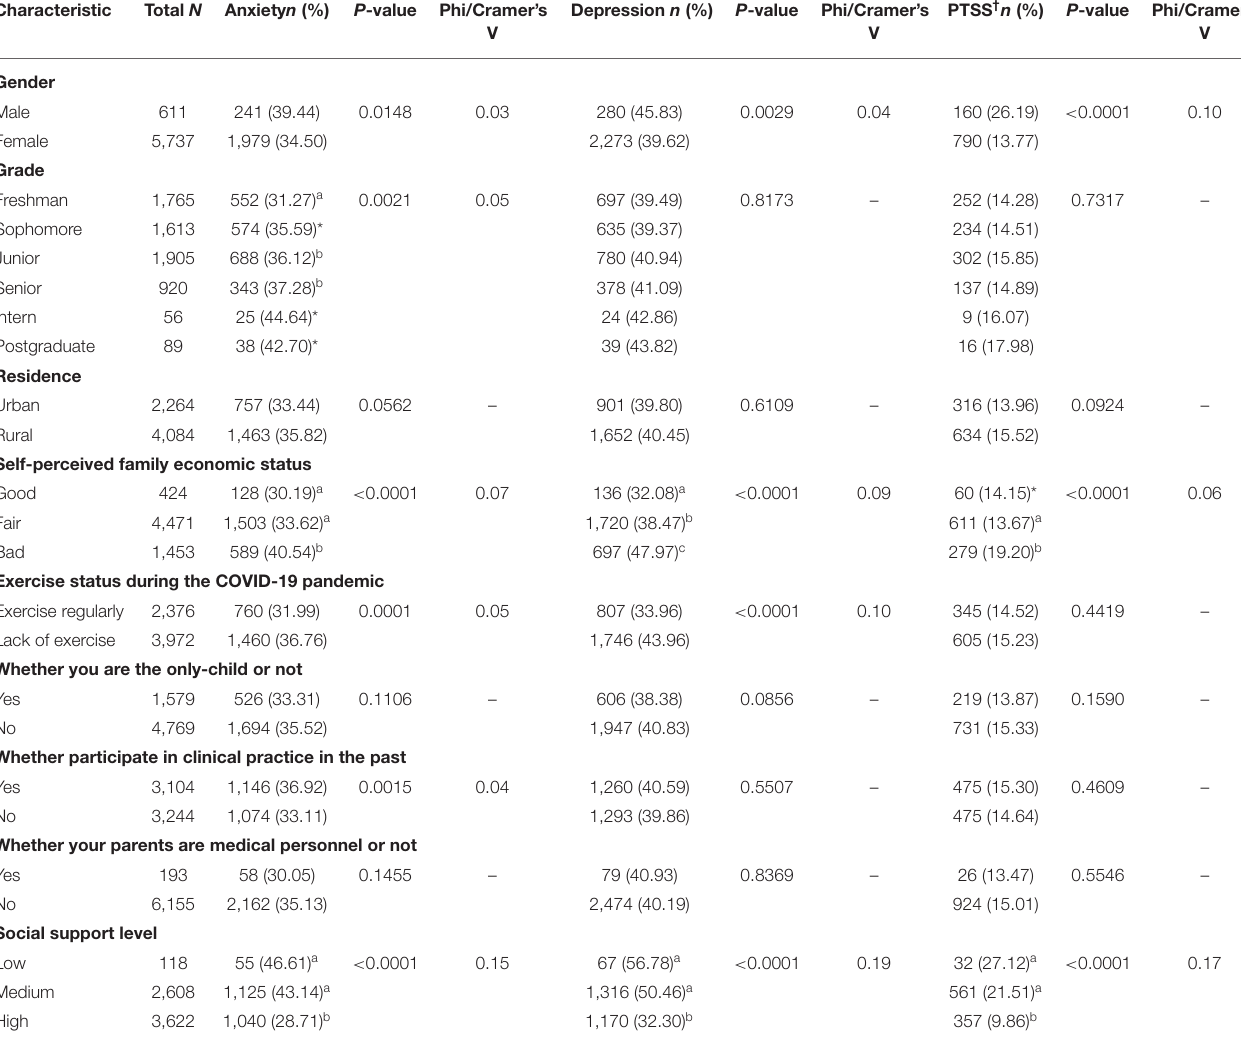
TABLE 3 | Anxiety, depression, and PTSS among nursing students with different sociodemographic characteristics and social support levels.